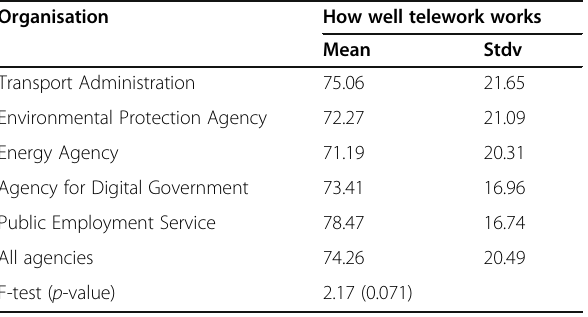
Table 4 Responses to the Question ‘ How Well Do You think Teleworking Works for You Now, During COVID-19 ” (Rating 1 – 100)? ’